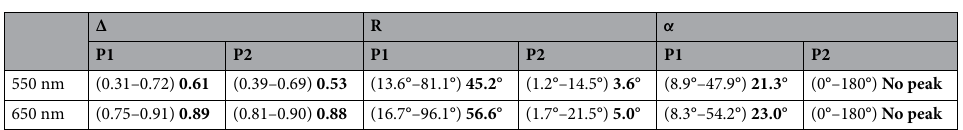
Table 1. Ranges of variability between the 5th and 95th percentile (in brackets) and the maximum values (in bold) of (cid:31) , R and α for P1 and P2 at 550 nm and 650 nm.